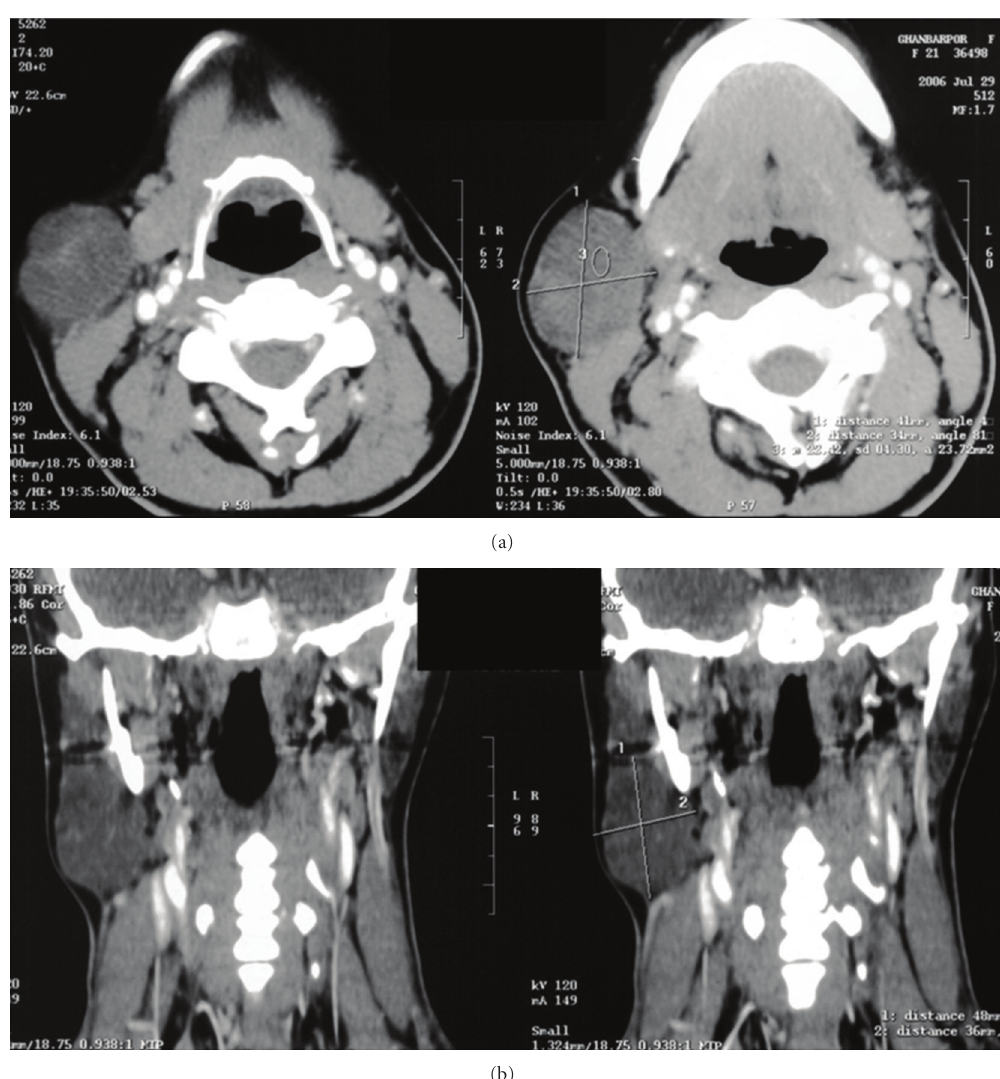
Figure 1: Contrast-enhanced CT scan in axial views of neck. A 36 × 48mm soft tissue mass shown in the right side of the neck, in association of submandibular salivary gland and extra sheath of carotid, and without any invasion to peripheral